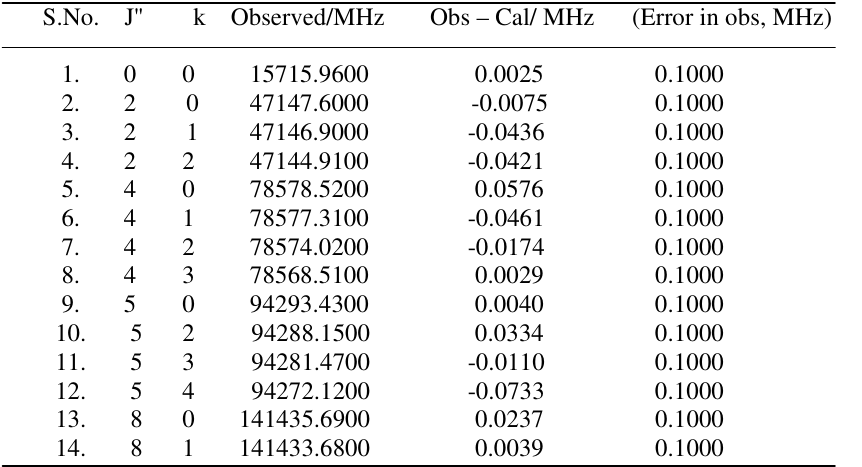
CN in Ground State for J = 17 3 CN in the Ground 3